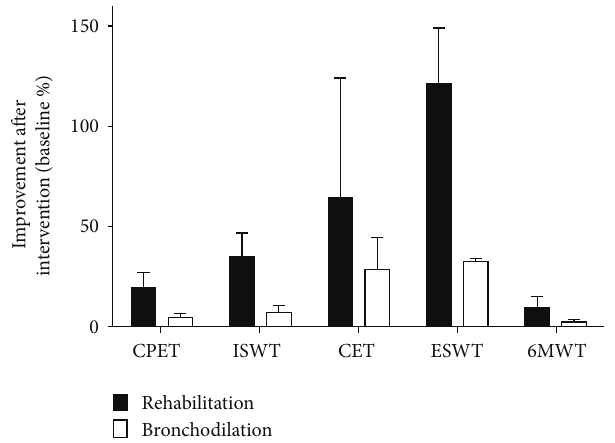
Figure 2: The impact of interventions on the exercise performance following testing methodologies in COPD population. With